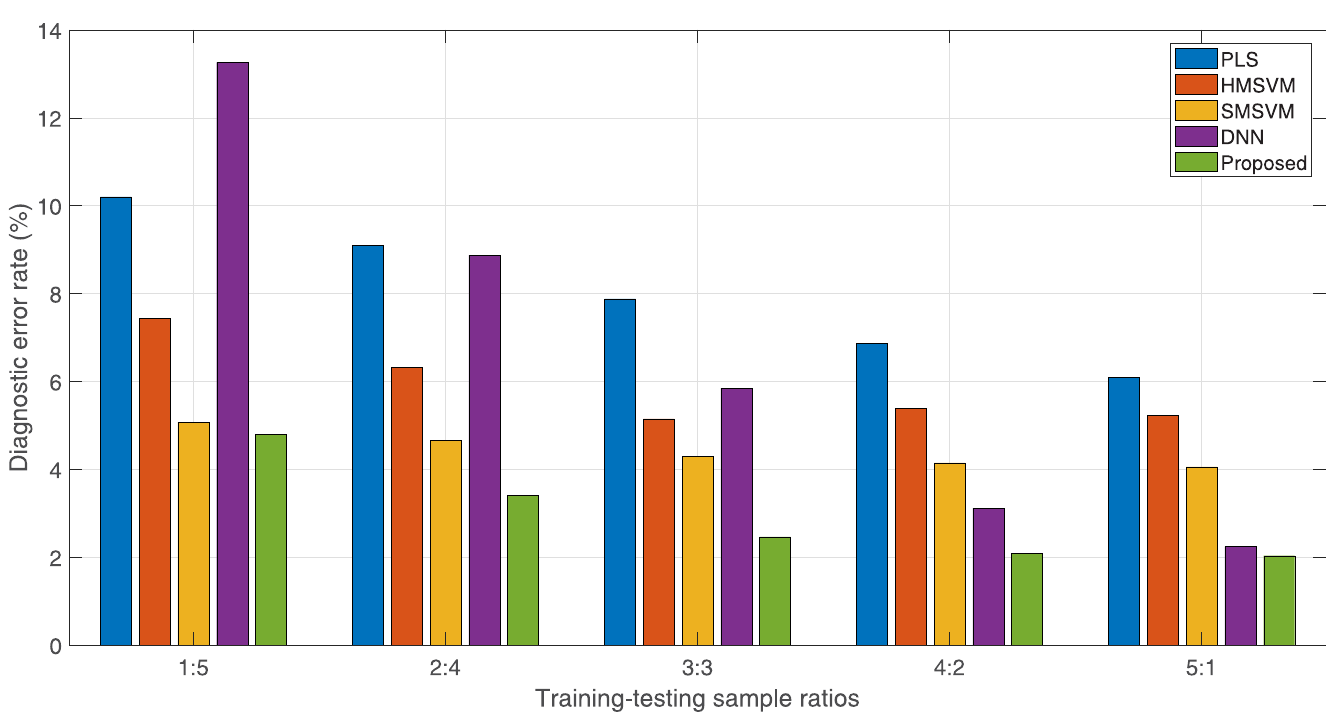
Fig 13. Average diagnostic error